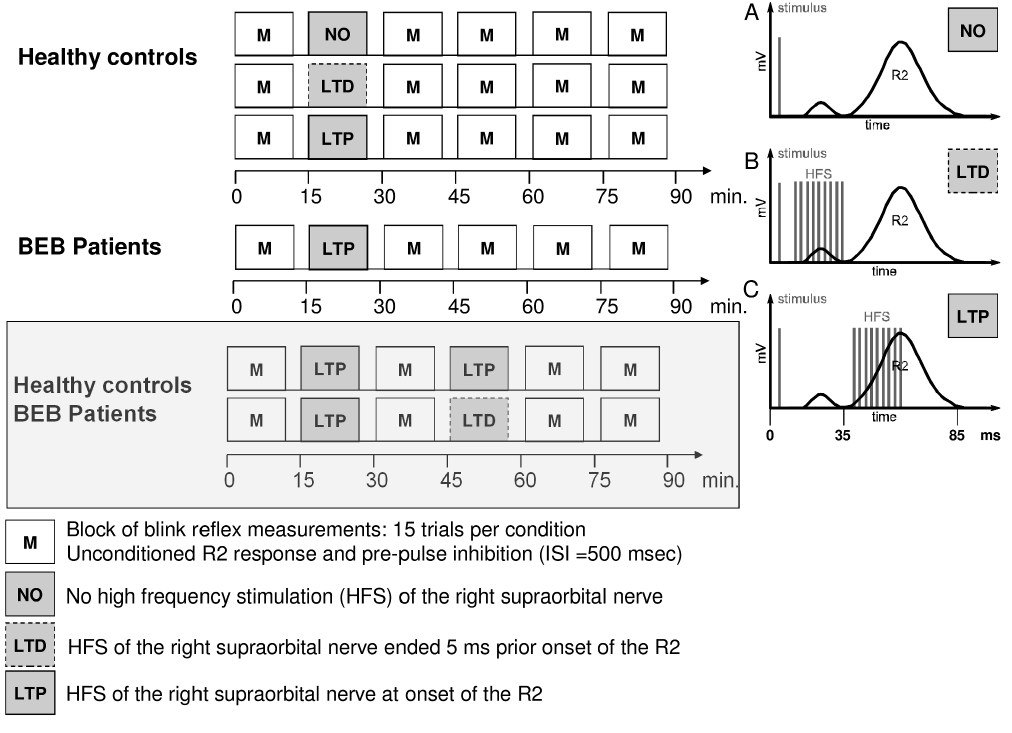
Figure 1. Assessing the dynamic modification range of LTP-LTD-like plasticity. Different protocols of high frequency stimulation (HFS) are presented. In controls and patients HFS LTP , HFS LTP-LTD , HFS LTP-LTP protocols were investigated. The HFS LTD and HFS NO protocol in controls served as control condition. In the right panel the timing for each intervention is illustrated. Panel A: The R1 and R2 answers are illustrated. In the non- intervention protocol, no high frequency stimulation was applied. Panel B: The high frequency stimulation ended 5 ms before the expected R2 response to induce LTD like effects. Panel C: The HFS started with the onset of the R2 answer to induce LTP like plasticity. doi:10.1371/journal.pone.0013602.g001 PLoS ONE |